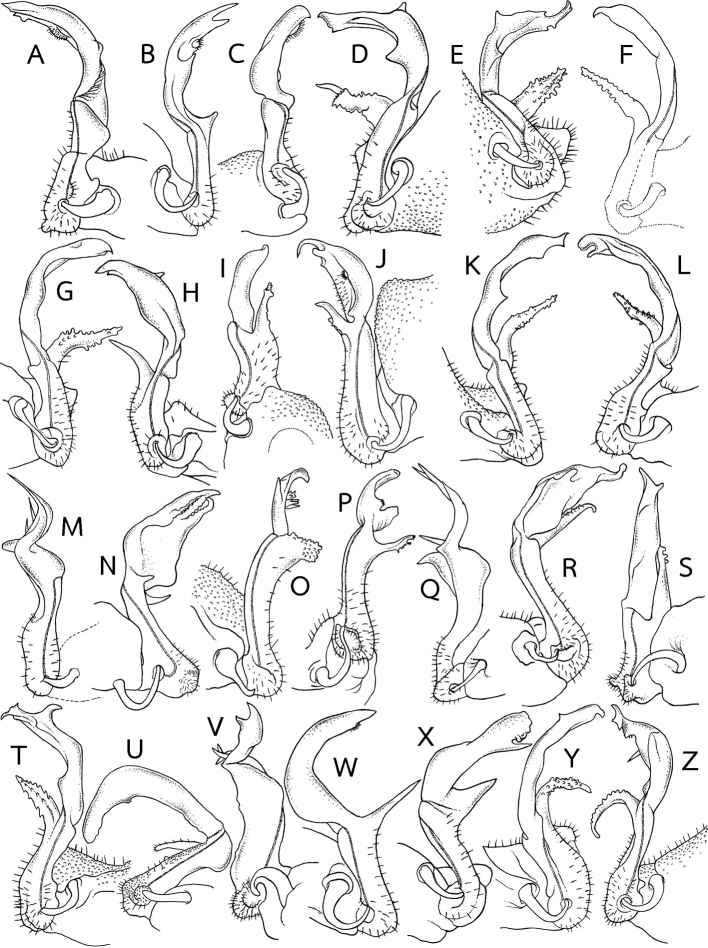

Gonopod
outline (mesal view of left and right gonopod) in several Eutrichodesmus species. All species without mid-dorsal projections on metaterga. AE.
filisetigerBE.
gremialisCE.
griseusDE.
incisusEE.
jianjiaFE.
latellaiGE.
latusHE.
monodentusIE.
multilobatusJE.
nadanKE.
obliteratusLE.
parvusME.
peculiarisNE.
planatusOE.
reductusPE.
regularisQE.
silvaticusRE.
similisSE.
simplexTE.
sketiUE.
spinatusVE.
taiwanensisWE.
tenuisXE.
triangularisYE.
troglobius and ZE.
trontelji. Not to scale. Figures modified from D, G, RGolovatch et al. (2009a)A, C, I, O, PGolovatch et al. (2009b)B Hoffman (1982) ELiu and Wynne (2019)F, K, T, W, X, Y, ZGolovatch et al. (2015)H Zhang in Zhang and Wang (1993)JGolovatch et al. (2016)LLiu and Wesener (2017)MMurakami (1966)N, S, ULiu and Tian (2013)QHaga (1968) and VGolovatch et al. (2010).